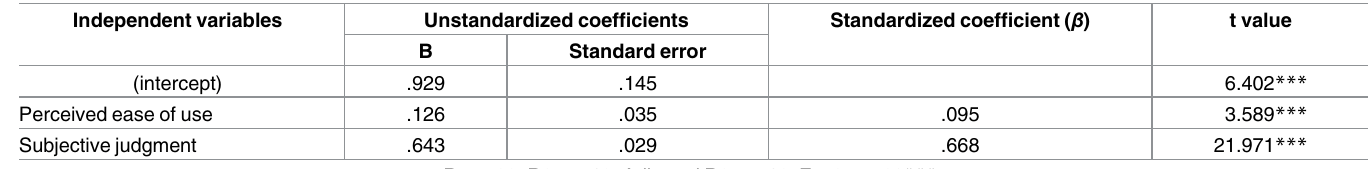
Table 4. Path analysis coefficient summaryof “subjective judgment” and “perceived ease of use” to